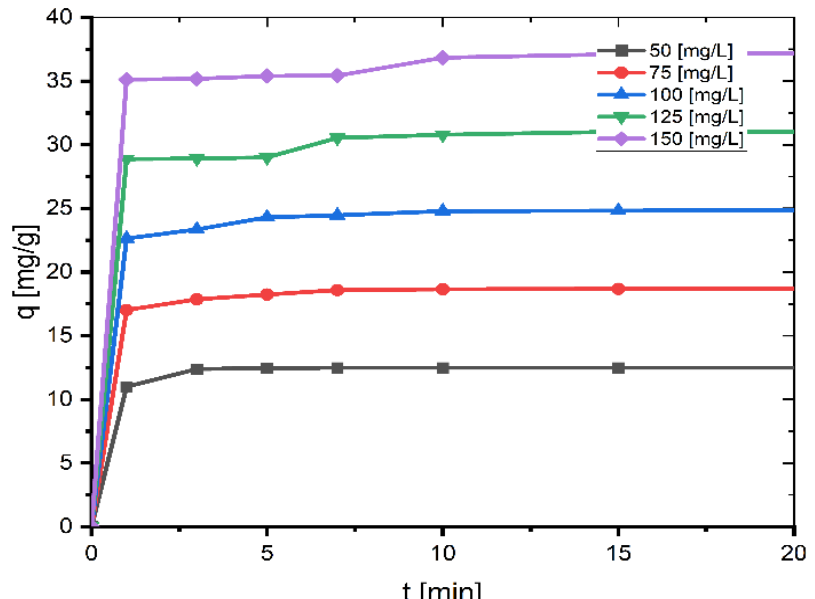
Figure 1. Effect of contact time and initial concentration on adsorption of MB onto coal (mass of coal = 0.1 g; volume of MB solution = 25 mL; T = 299.15 K, pH = 6.35). Figure 2 represents the equilibrium absorption capacity versus the initial dye con- centration (50–150 mg/L).